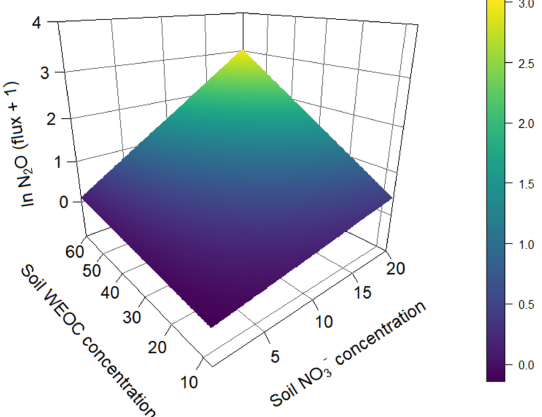
Figure 5. Prediction of N 2 O fluxes (pgN 2 O-Ng − 1 s − 1 ) (ln trans- formed) based on soil NO − (µgNg − 1 ) and water-extractable C org 3 (µgCg − 1 ) concentrations based on a linear mixed-effect model (pseudo- R 2 = 0 .